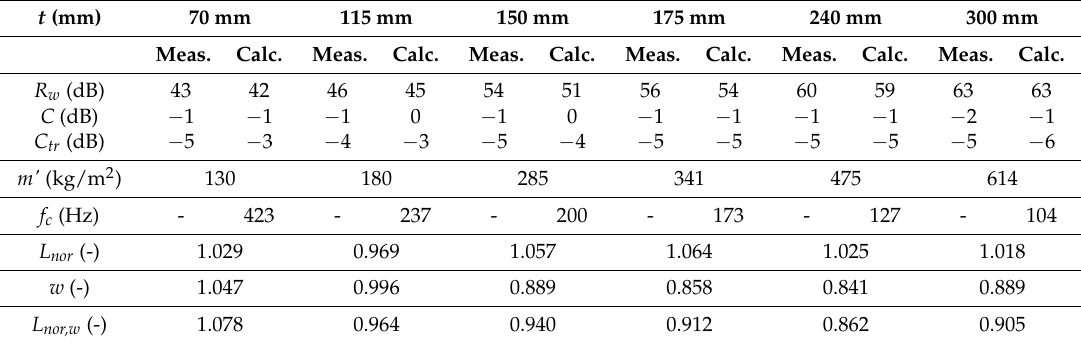
Table 1. Calculated 1 and measured R - and R w - values, and related values. Signal: pink noise.